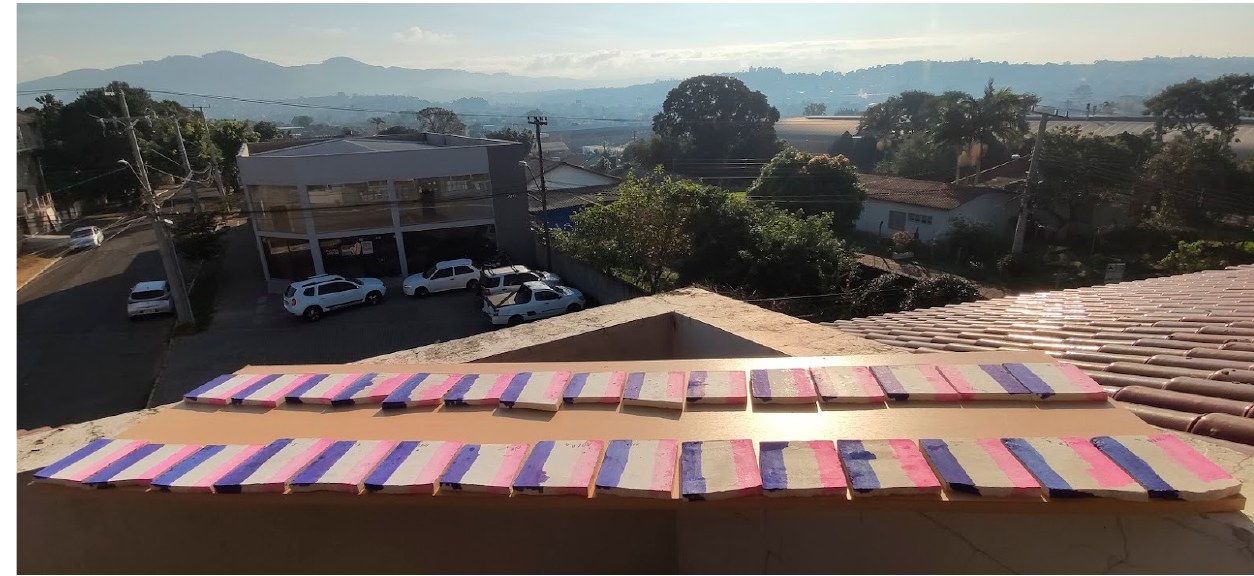
Figure 5. Tiles stained by rhodamine B and methylene blue exposed to the urban environment.